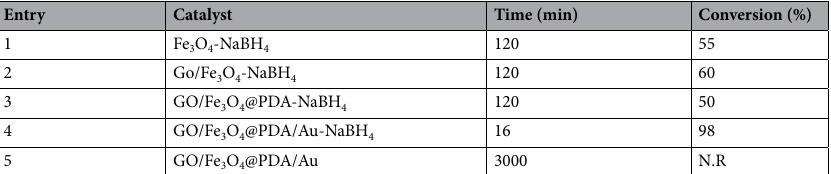
Table 1. The control experiments for the reduction of 4-NP to 4-AP. Reaction conditions: 0.3 mL of 0.003 M 4-NP, 0.05 mL of 1 mg mL −1 catalyst, and 0.3 mL of 1.2 (M) NaBH 4 solution in water.